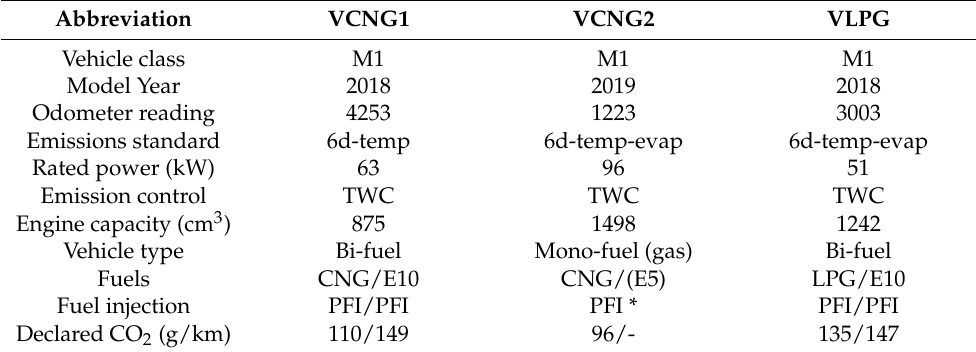
Table 1. Characteristics of the tested